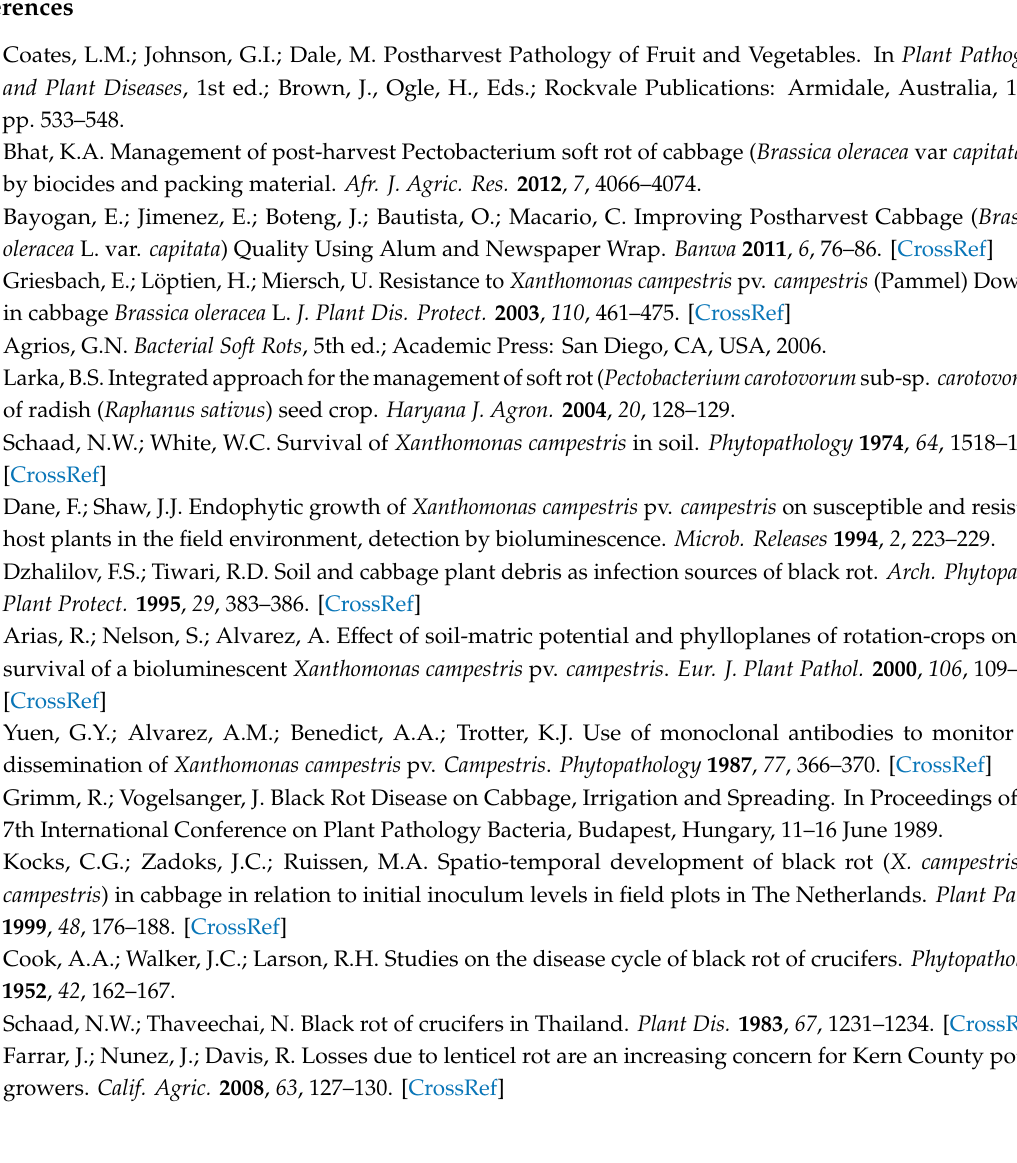
Figure S1: Definition of cabbage stalks, inner leaves and superficial leaves; Figure S2: Symptoms on Xcc-inoculated cabbage heads after storage; Figure S3: Symptoms on non-inoculated cabbage heads after